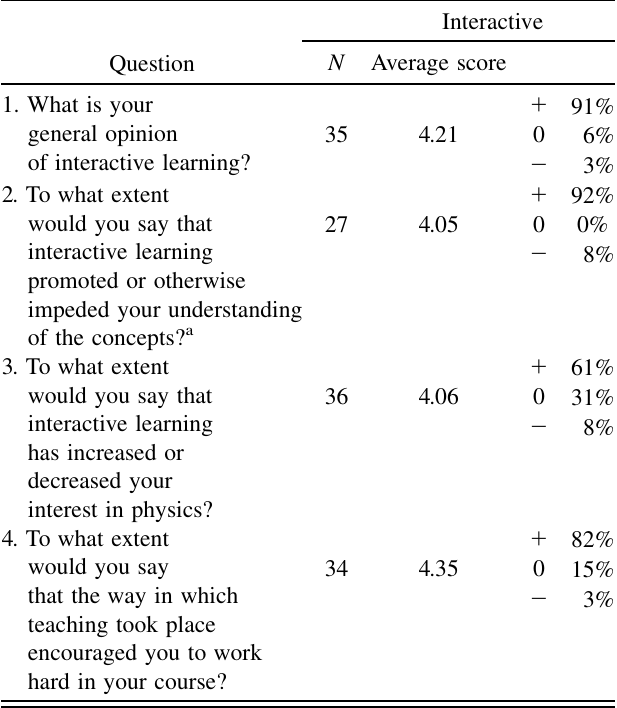
TABLE X. Midterm student attitudes in one second-year E&M class